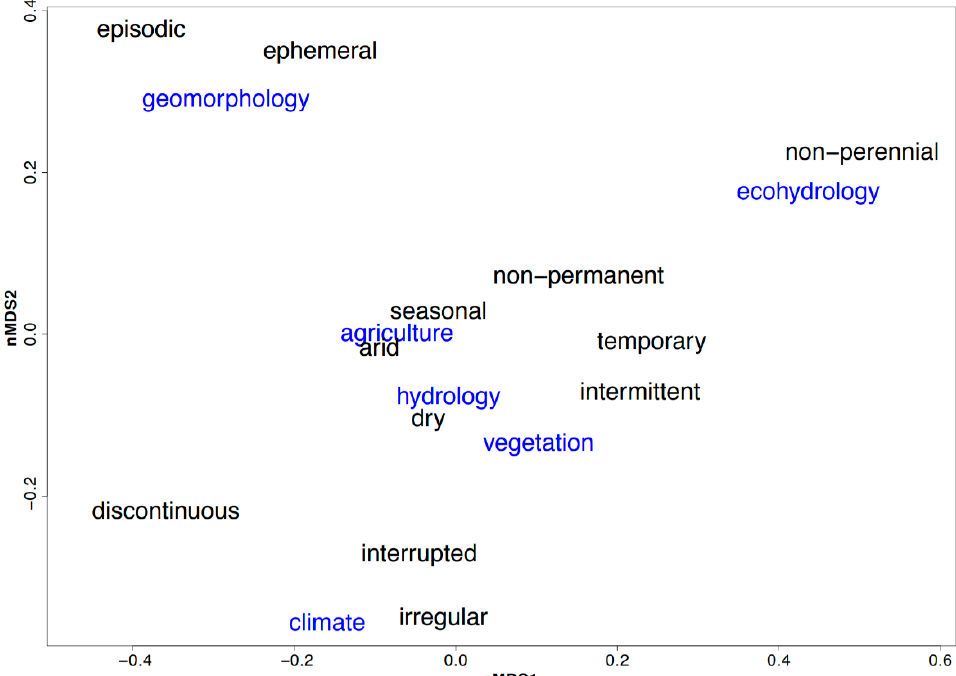
Figure 2. A non-metric multidimensional scaling (nMDS) ordination (stress = 0.1029) representing similarities among the six topics found from latent Dirichlet allocation (LDA) topic modeling (blue words) and how they relate to papers about each epithet (black words). The large sample size made plotting each paper too cluttered, so average probabilities of the topic appearing in papers across all twelve corpora were used to understand broad, topical terms between epithets.